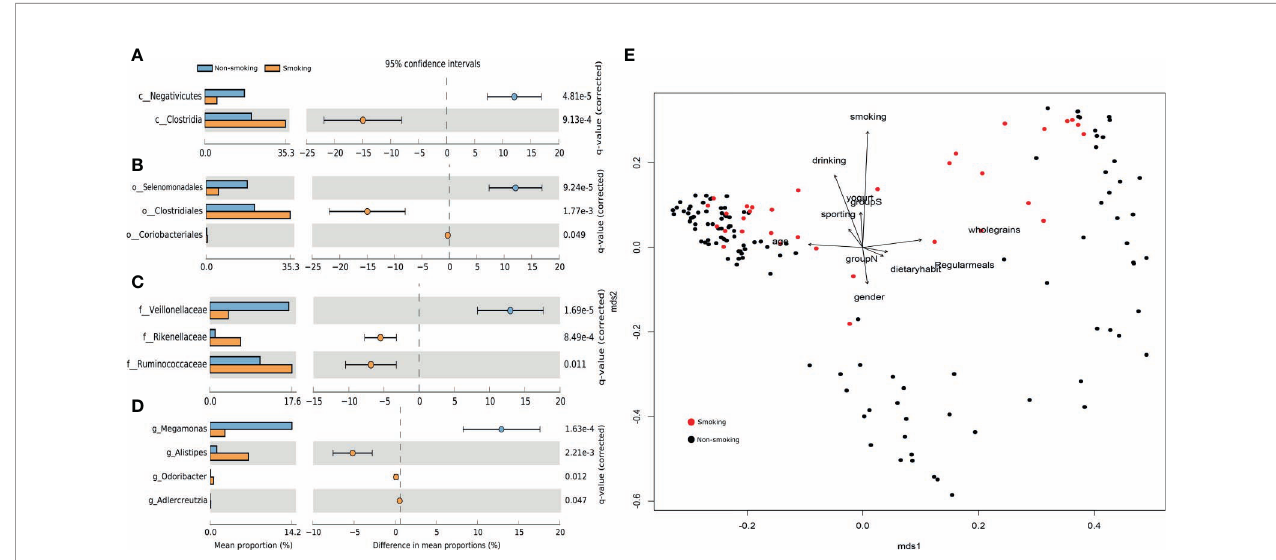
FIGURE 1 | Differences at each level and RDA analysis (A) class-level differences; (B) order-level differences; (C) family-level differences; (D) genus-level differences; (E) effects of dietary habits and individual attributes on micro fl